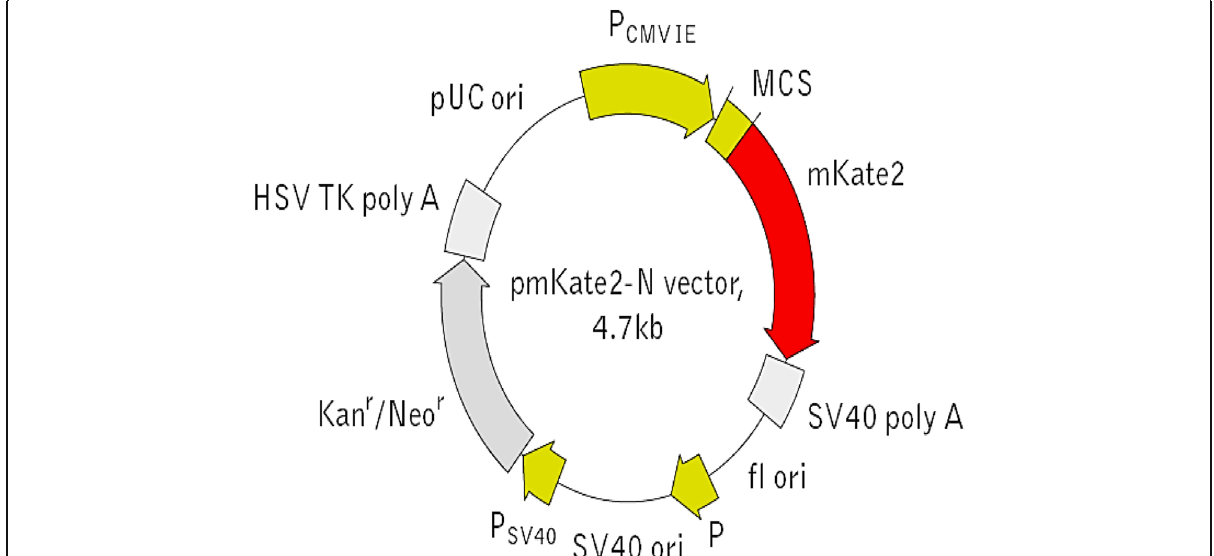
Fig. 1 The backbone of the pmKate2 – N expression vector. MCS, multiple cloning site for cloned insertion; mKate2, far-red fluorescent protein; PCMV IE, immediate early promoter of cytomegalovirus; SV40 ori, origin for replication in mammalian cells; pUC ori, origin of replication for propagation in E. coli ; f1 ori, origin for single-stranded DNA production; SV40 poly A, polyadenylation signals; PSV40, early promoter provides neomycin resistance gene (Neo r ) expression to select stably transfected eukaryotic cells using G418; P, bacterial promoter provides kanamycin resistance gene expression (Kan r ) in E. coli ; Kanr/Neor, gene is linked with herpes simplex virus (HSV) thymidine kinase (TK) polyadenylation